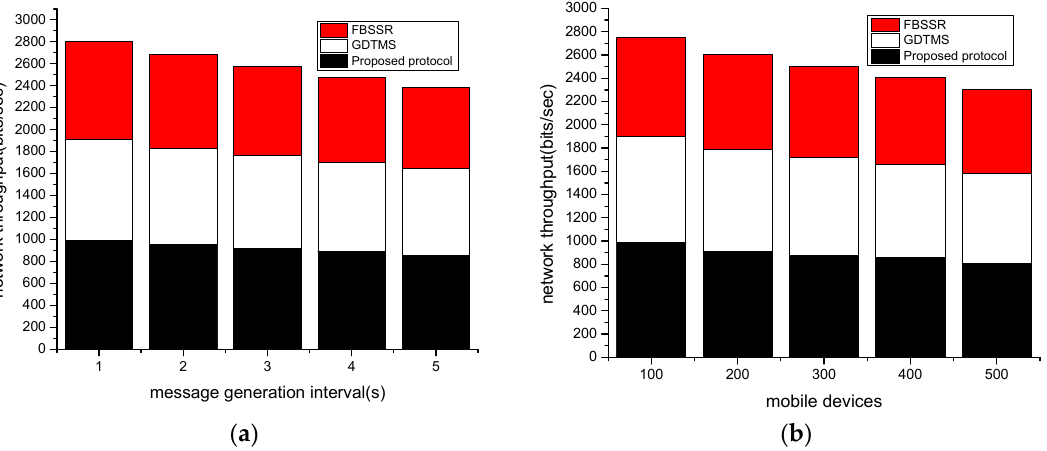
Figure 4. ( a ) Network throughput with message generation interval. ( b ) Network throughput with mobile devices.